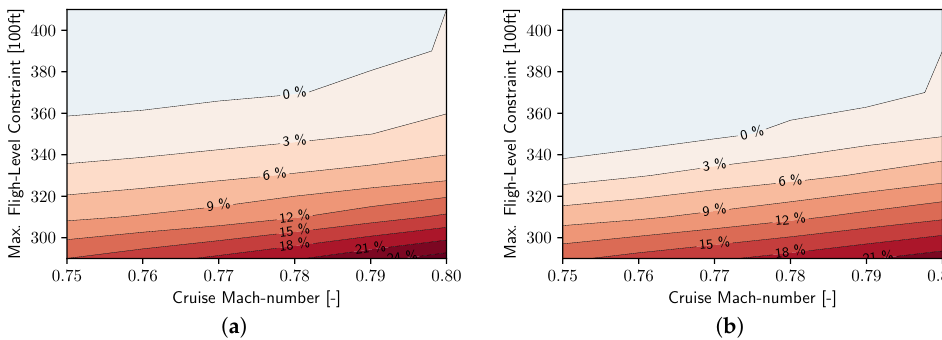
Figure 14. Block-Energy difference for PtL concept D261+SAF ( a ) and LH2 concept D261+H2 ( b